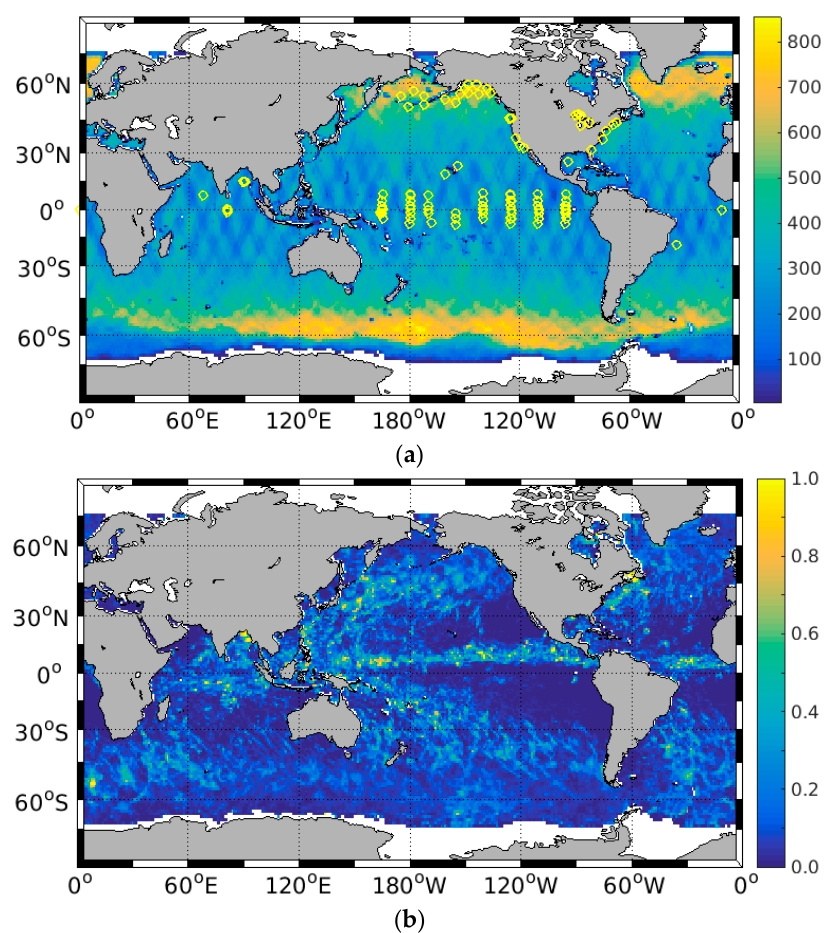
Figure 1. Spatial distribution of ( a ) the HSCAT-B—GMI collocations and ( b ) the GMI mean rain rate on a global map. Here, the collocations for 2021 are used. Color bars indicate the number of collocations ( a ) and the mean rain rate (mm/h). The yellow circles indicate the locations of the moored buoys used in this study.